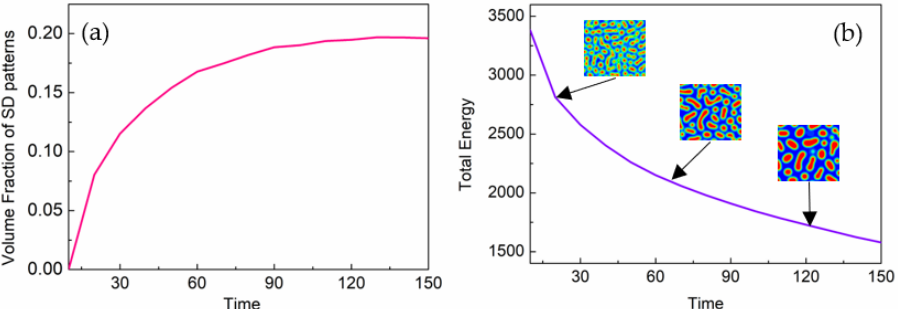
Figure 8. ( a ) Volume fraction of spinodal decomposition patterns; ( b ) time variation of the discrete free energy with the insets showing the microstructures at times indicated by the arrows.